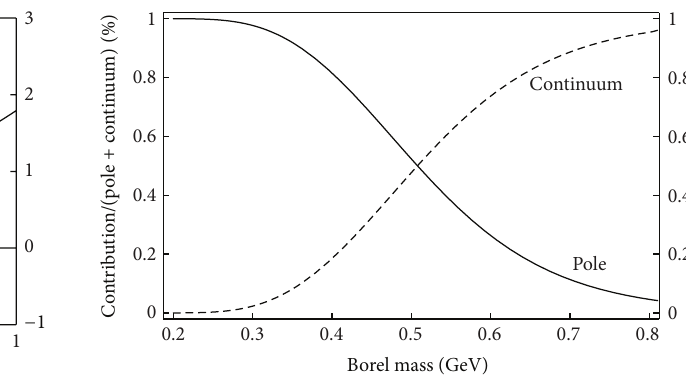
Figure 1: Spectral density for the current 𝜎 1+2 as a function of the energy 𝑠 .